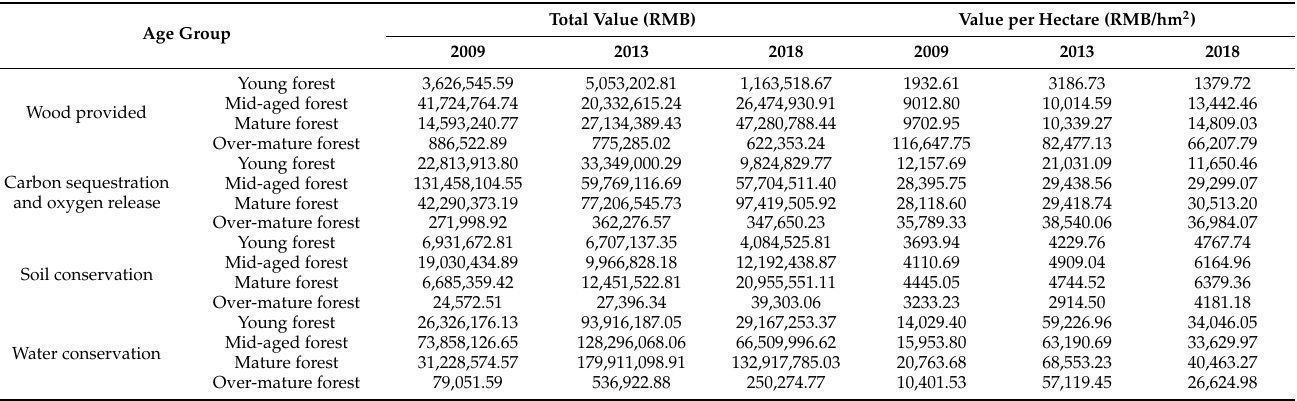
Table 4. Value of the four ESs of PM plantations in the differently aged forests in the northern tropical case study area in